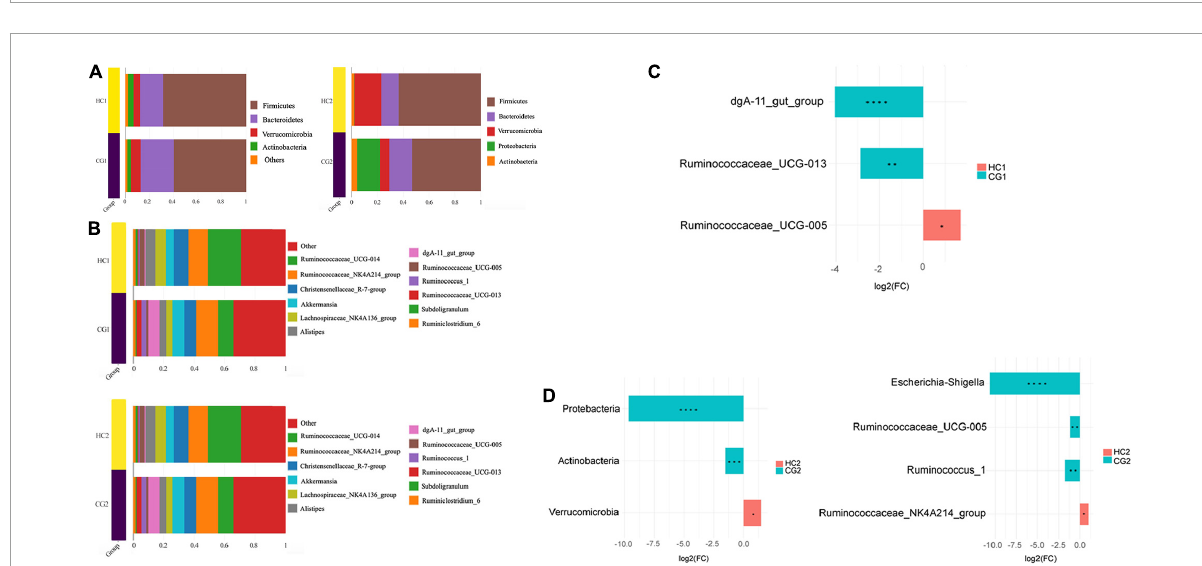
FIGURE3 The relative abundance of cecal microbiota in Ira rabbits. (A) Phylum level. (B) Genus level. (C) Between-group variance analysis of genus at 53 days of age. (D) Between-group variance analysis of phylum and genus at 67 days of age. CG1, control group at 53 days of age; CG2, control group at 67 days of age; HC1, the high dose at 53 days of age; HC2, the high dose at 67 days of age. In the figure, * means P < 0.05, ** means P < 0.01, *** means P < 0.0001, **** means P < 0.0001, the same as in the figure